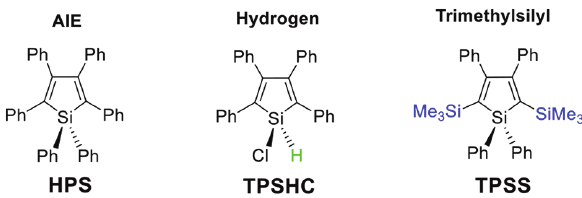
Scheme 1: Chemical structures of HPS, TPSHC, and TPSS.